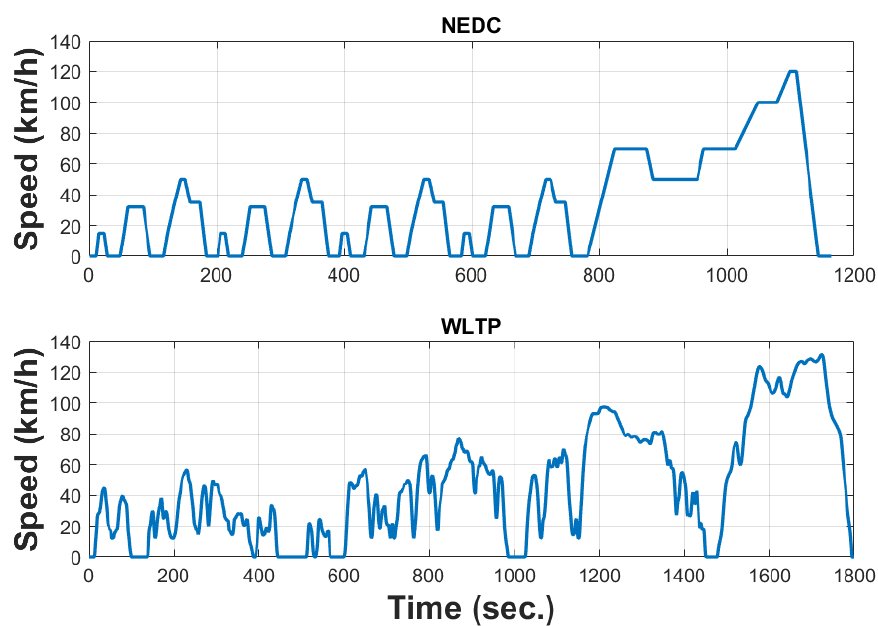
Figure 11. NEDC (top) and WLTP (bottom).